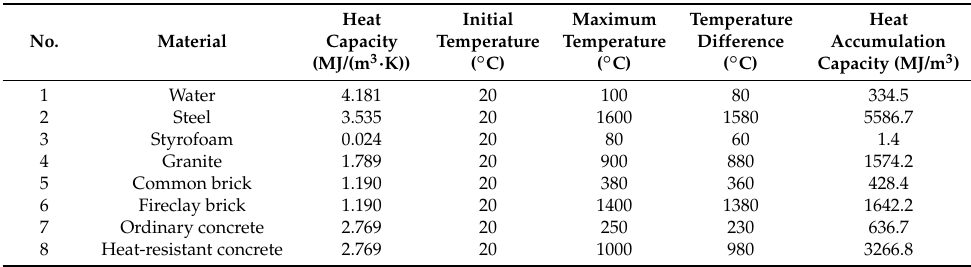
Table 2. The maximum amount of the thermal energy, which can be stored in a unit volume of the